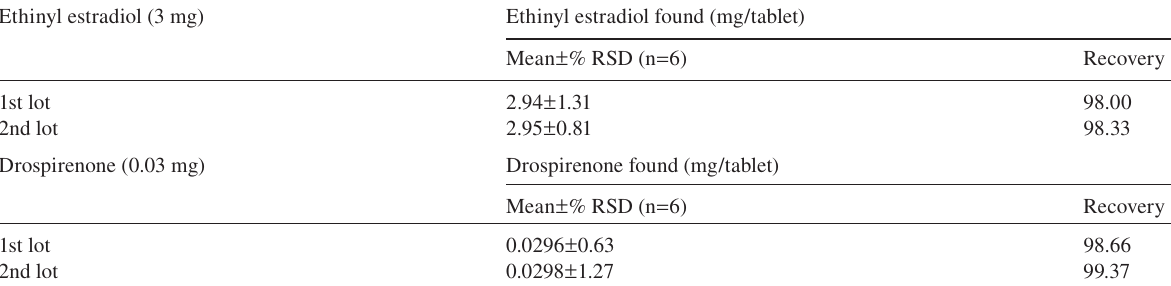
Table 4 Analysis of commercial